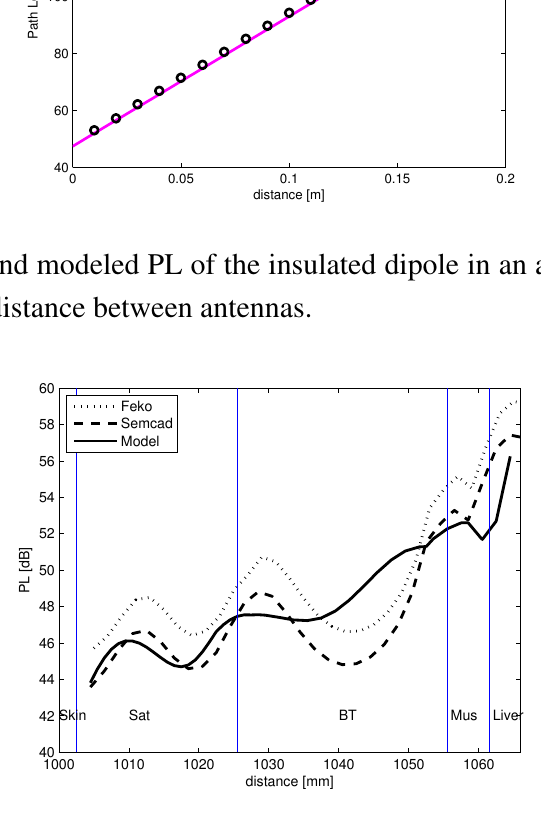
Figure 7. Simulated (FEKO and SEMCAD-X) and PL model of the insulated dipole in multilayer lossy medium versus the separation distance between